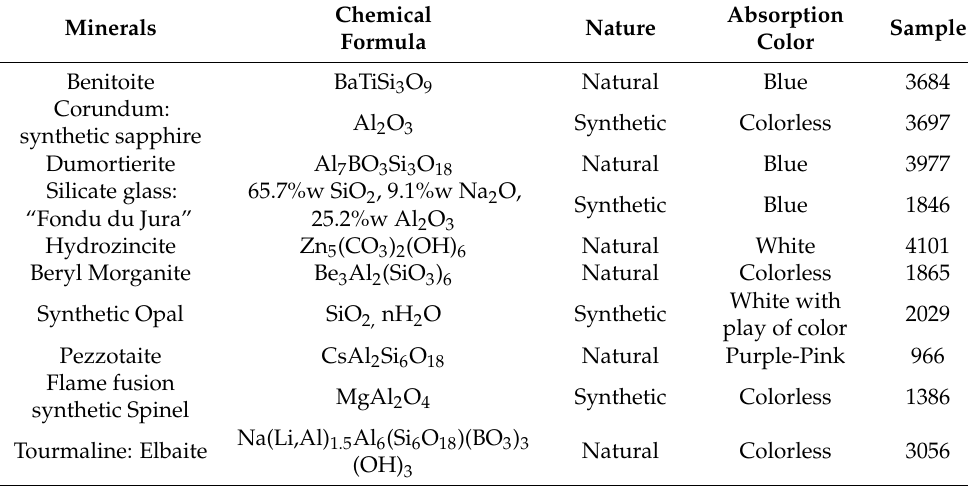
Absorption Chemical Sample Nature Color Formula Al 2 O 3 Synthetic Colorless 3697 White with play of color